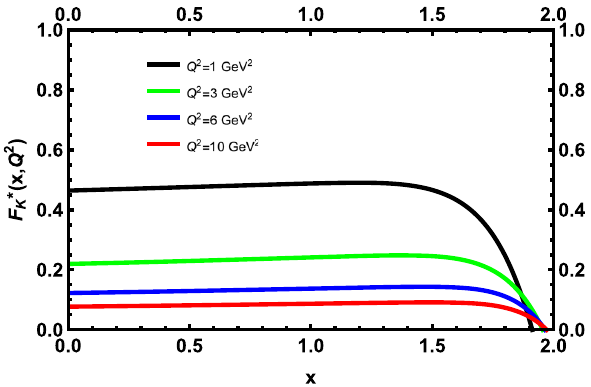
( Q 2 , x ) with respect to the density of the K